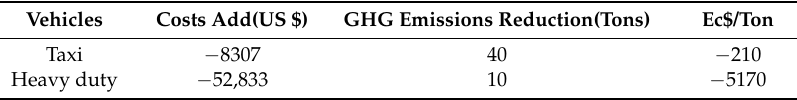
Table 15. Comparison of results for NG fuel vehicles and CVs.